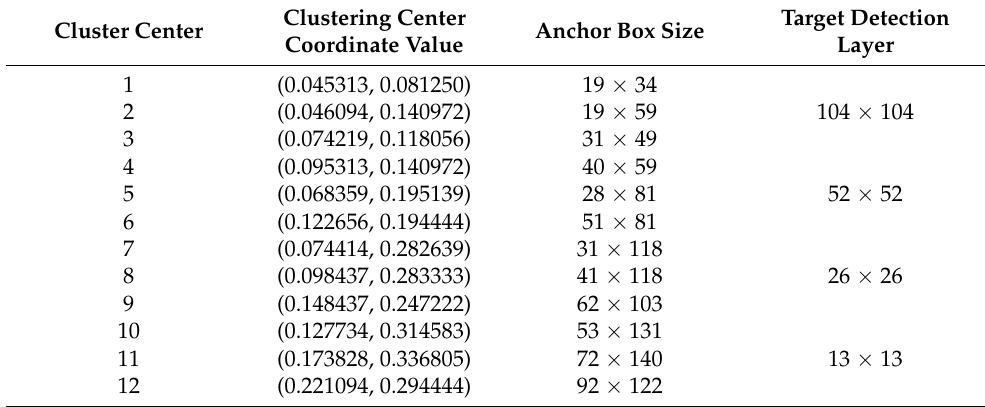
Table 1. Clustering center coordinate values and anchor box size